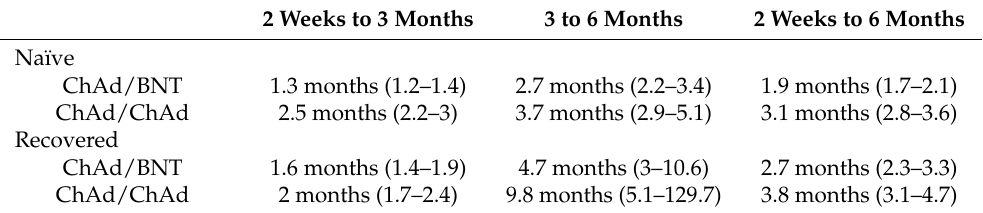
Figure 1. Change in anti-spike IgG titers over 6 months following vaccination. Circles represent individual values, lines represent geometric mean titer with 95% CI in ( A ) participants SARS-CoV-2 naïve prior to vaccination and ( B ) participants SARS-CoV-2 recovered prior to vaccination. ChAd; ChAdOx1 nCoV-19 vaccine, BNT; BNT162b2 mRNA vaccine. Table 2. Estimated half-life at different sampling points after both vaccine regimens in participants either SARS-CoV-2 recovered or naïve prior to vaccination. ChAd; ChAdOx1 nCoV-19 vaccine, BNT; BNT162b2 mRNA